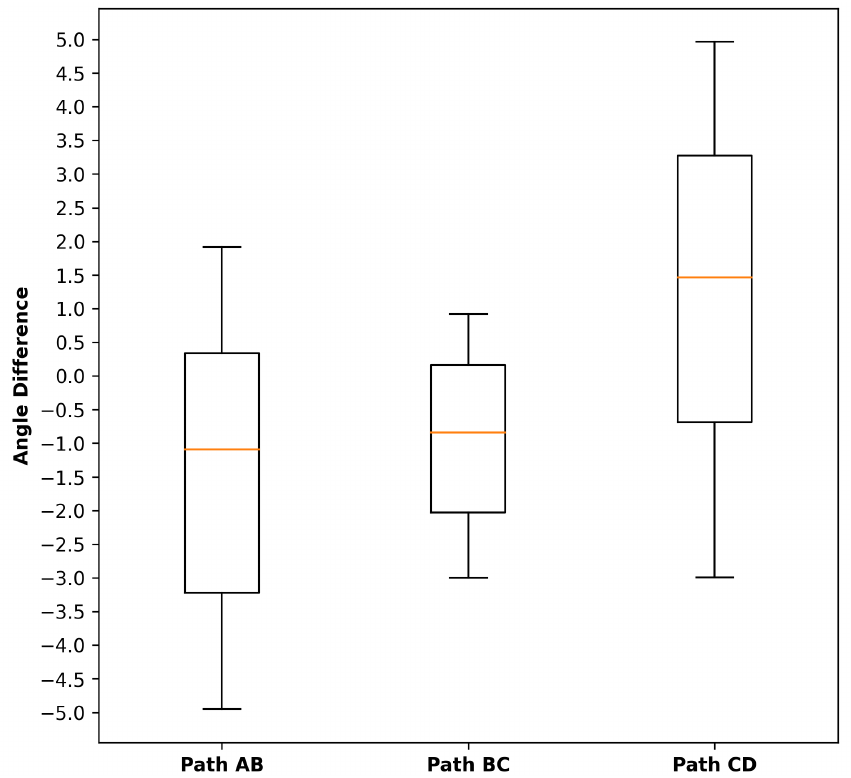
Figure 13. Angle difference between RRT path, and UAV